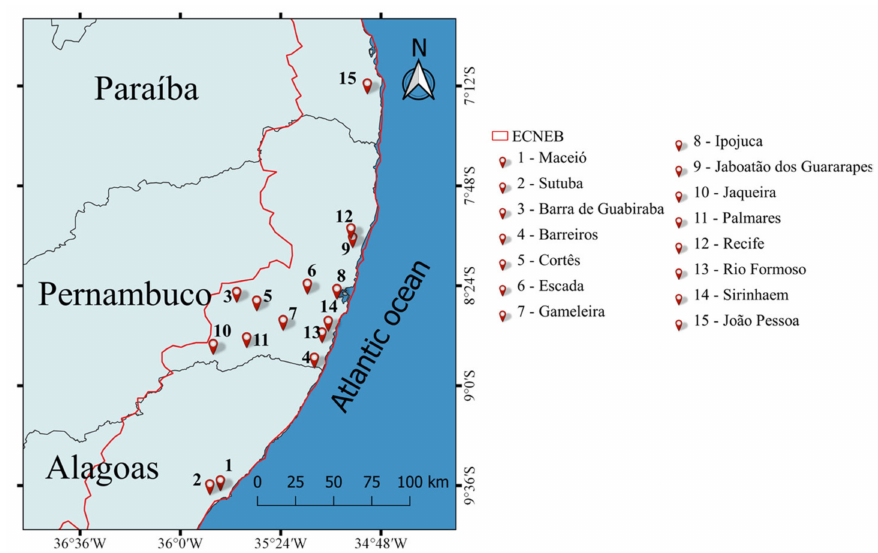
Figure 3. Location of CEMADEN rainfall